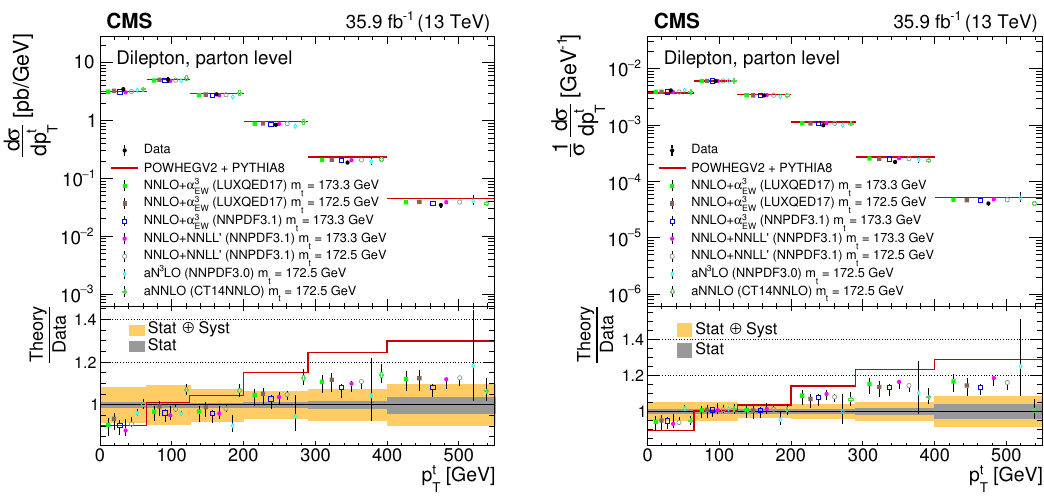
Figure 4 . The di(cid:11)erential tt production cross sections at the parton level in the full phase space as a function of p t are shown for the data ((cid:12)lled circles), the theoretical predictions with beyond-NLO T precision (other points) and the prediction from powheg + pythia (solid line). The vertical lines on the (cid:12)lled circles and other points indicate the total uncertainty in the data and theoretical predic- tions, respectively. The left and right plots correspond to absolute and normalised measurements, respectively. The lower panel in each plot shows the ratios of the theoretical predictions to the data. The dark and light bands show the relative statistical and total uncertainties in the data, respectively.